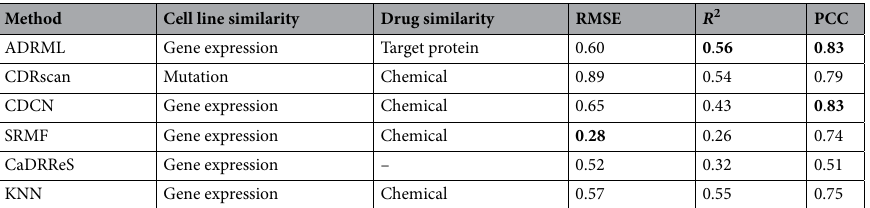
Table 5. Comparison of methods’ performance on the purified CCLE dataset. The methods were evaluated by averaging over 30 repetitions of fivefold cross-validation on cell line-drug pair. The best result of each criterion is shown in